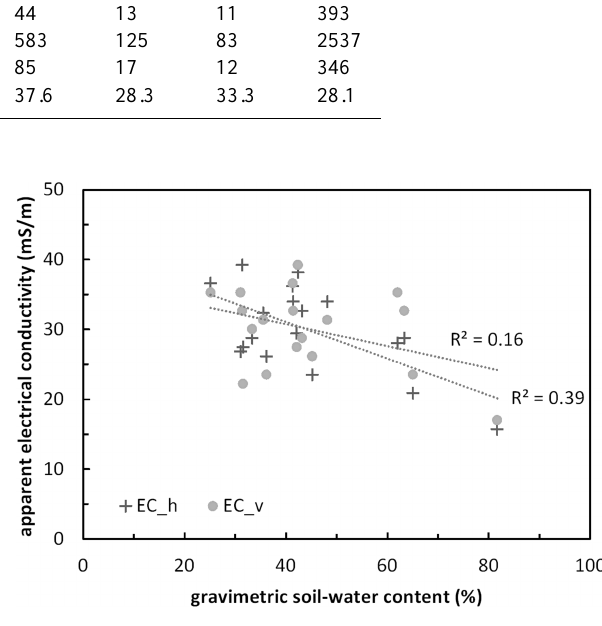
Fig. 3. Scatterplot of gravimetric soil-water content and ECa data, separated into EC h and EC v according to the respective sensor orientation in June